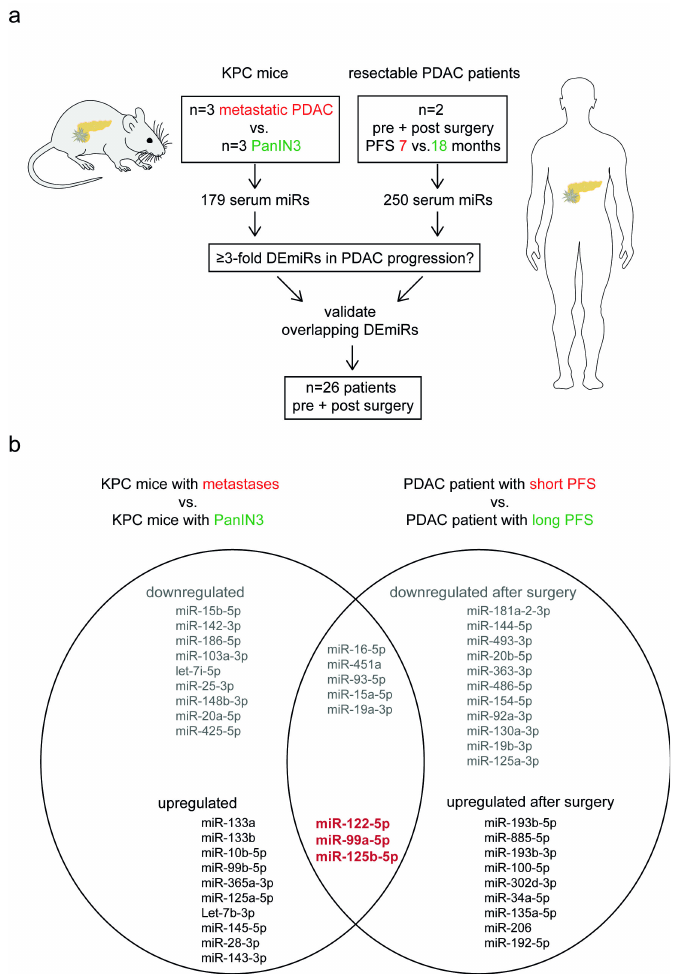
Figure 1. Overview of the serum miR screening in mice and patients to identify miRs associated with pancreatic cancer progression. ( a ) Schematic of performed RT-qPCR based miR discovery. Serum miRs from two groups of LSL-Kras G12D /+ ; LSL-Trp53 R172H /+ ; P48-Cre (KPC) mice with di ff erent disease stages were analyzed for association with PDAC progression. Additionally, two patients with resectable PDAC were screened for expression of serum miRs to identify indicators of progression free survival (PFS) after surgical tumor removal. Overlapping di ff erentially expressed miRs (DEmiRs) were selected for validation in an additional cohort of patients. ( b ) List of ≥ 3-fold DEmiRs that are associated with PDAC progression in KPC mice (left circle) and patients (right circle), identified in the miR screening. Upregulation of the miRs in bold red were associated with progressive PDAC in both mice and patients. These miRs were selected for